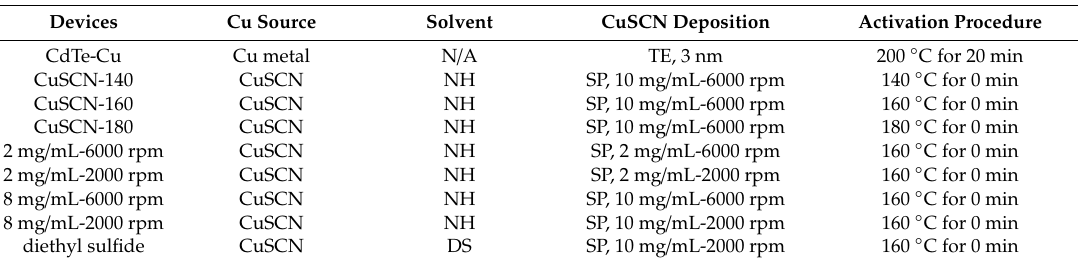
Table 1. Details of all devices fabricated in this work. Note that the bu ff er layer, CdTe layer, and CdCl 2 treatment are identical for all the devices as mentioned